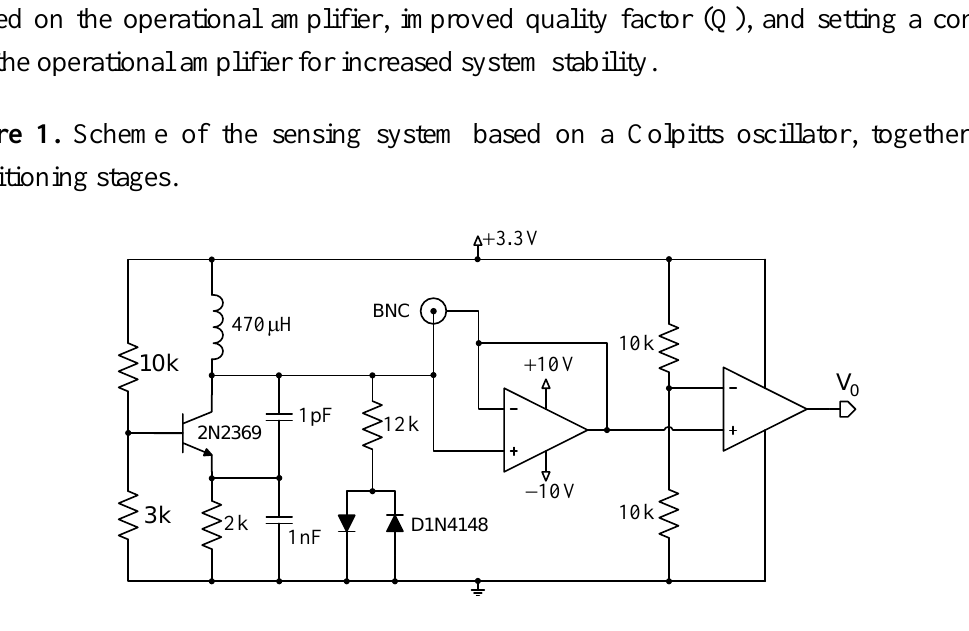
Figure 1. Scheme of the sensing system based on a Colpitts oscillator, together with conditioning stages.